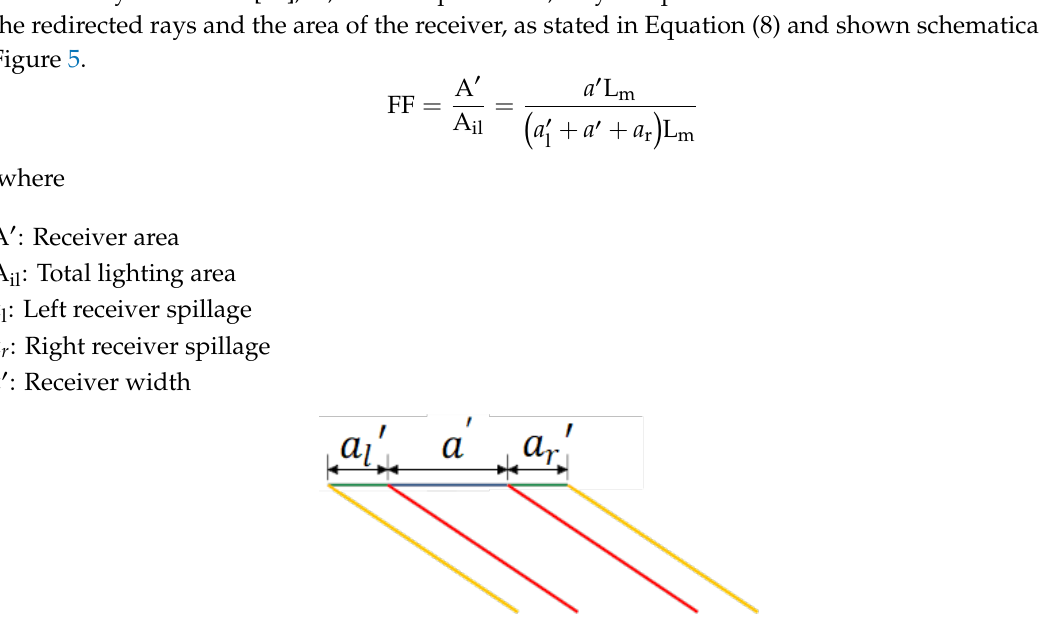
Figure 5. Schematic diagram of the cross-section of the receiver area.